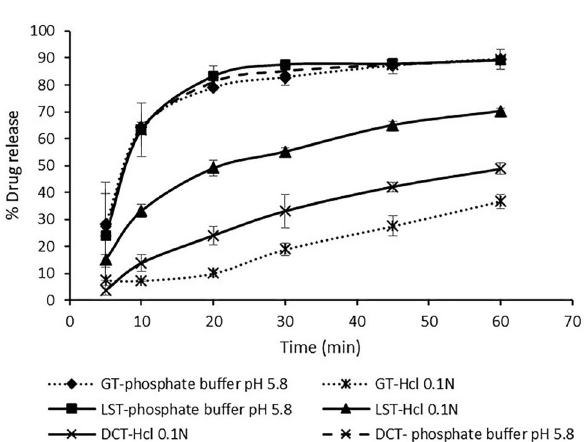
Figure 7. Percentage drug release of FUR from various tablets against time (min) in different mediums. Data are expressed as mean ± SD (n =